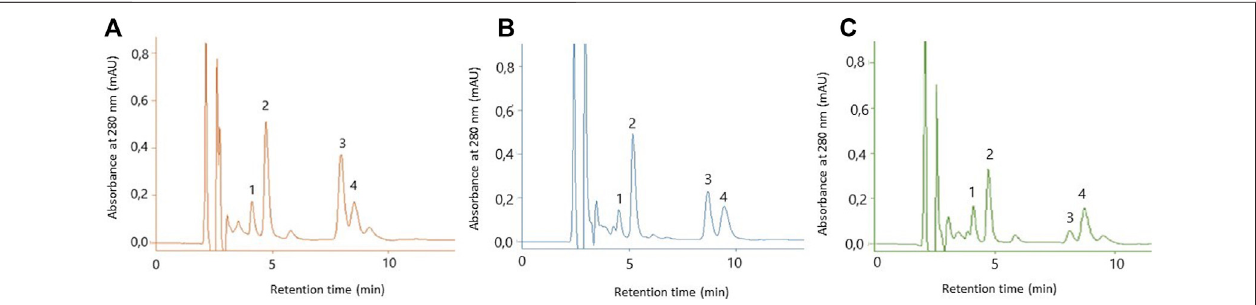
FIGURE2| HPLC chromatogramofhydrogels.The hydrogel contained dryethanolextract of E.angustifolium (A) ;the hydrogel containingdry isopropanolextract of E. angustifolium (B) ; The hydrogel contained dry water extract of E. angustifolium (C) , 1 — gallic acid; 2 – 3,4 -hydroxybenzoic acid; 3 – 3-hydroxybenzoic acid; 4 – 4- hydroxybenzoic